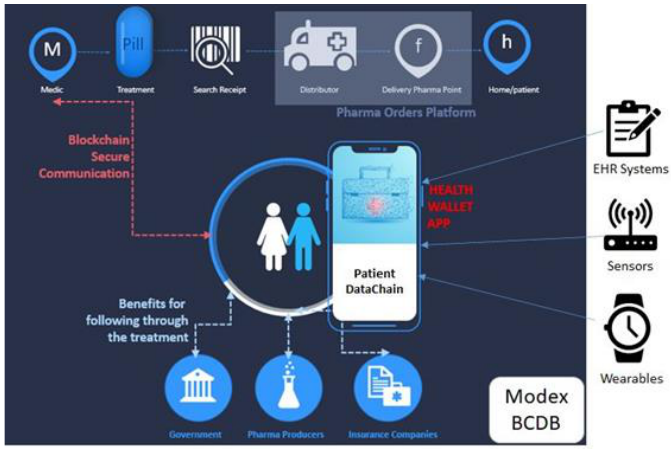
Figure 4. PatientDataChain high-level architecture .